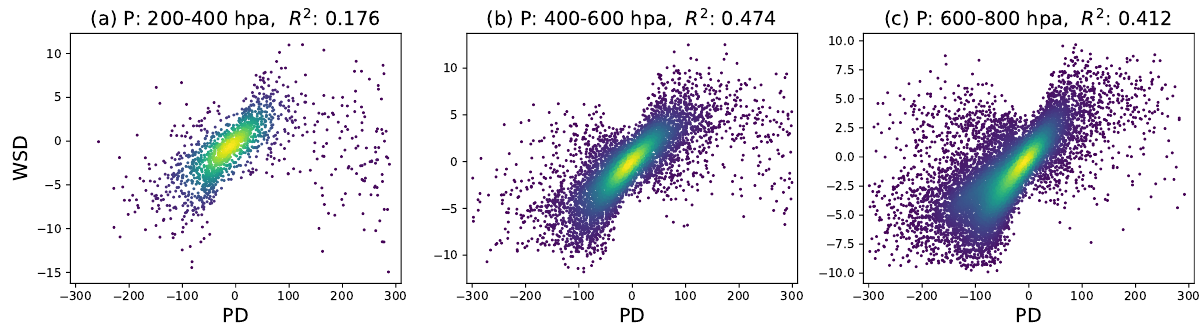
Figure 7 displays scatter plots of PD values and wind speed difference between the observation and the model background winds (hereafter referred to as WSD). Overall, PD and WSD has a strong correlation. Positive PD values are associated with positive (fast) wind speed biases, and negative PD values are associated with negative (slow) wind speed biases. In the lower layer (600–800 hPa), there are notably more negative PD than positive PD values. Therefore, the EBBT method tends to assign clouds high, which causes slow wind speed biases, as shown in both Figures 4 and 5. The WV and VIS winds of GK2A show almost identical features as the IR winds (not shown).